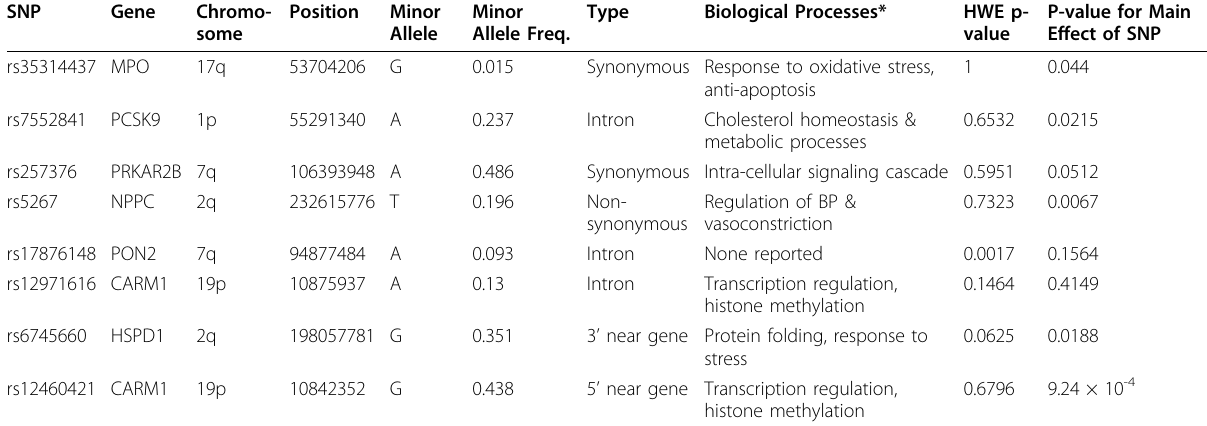
Table 5 Positional and functional details of SNPs included in the final multivariable model